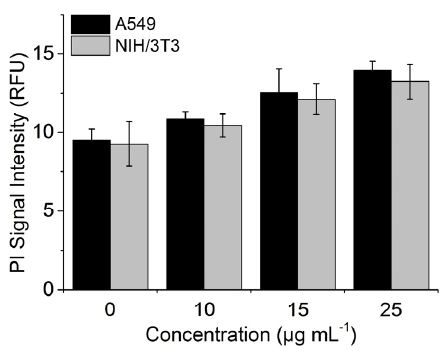
Figure 8. Fluorescence signal of A549 and NIH/3T3 cells after incubation with different TiO 2 NP concentrations.